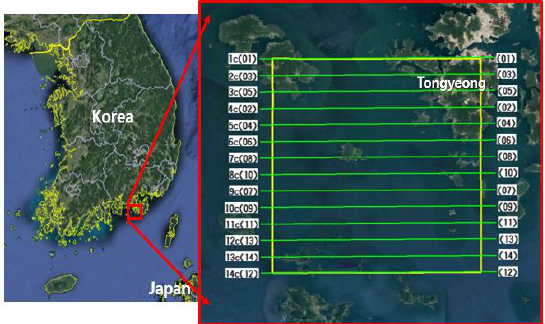
Figure 1 . Study area of the coastal area around Tongyeong, South Korea and the planned flight lines for hyperspectral